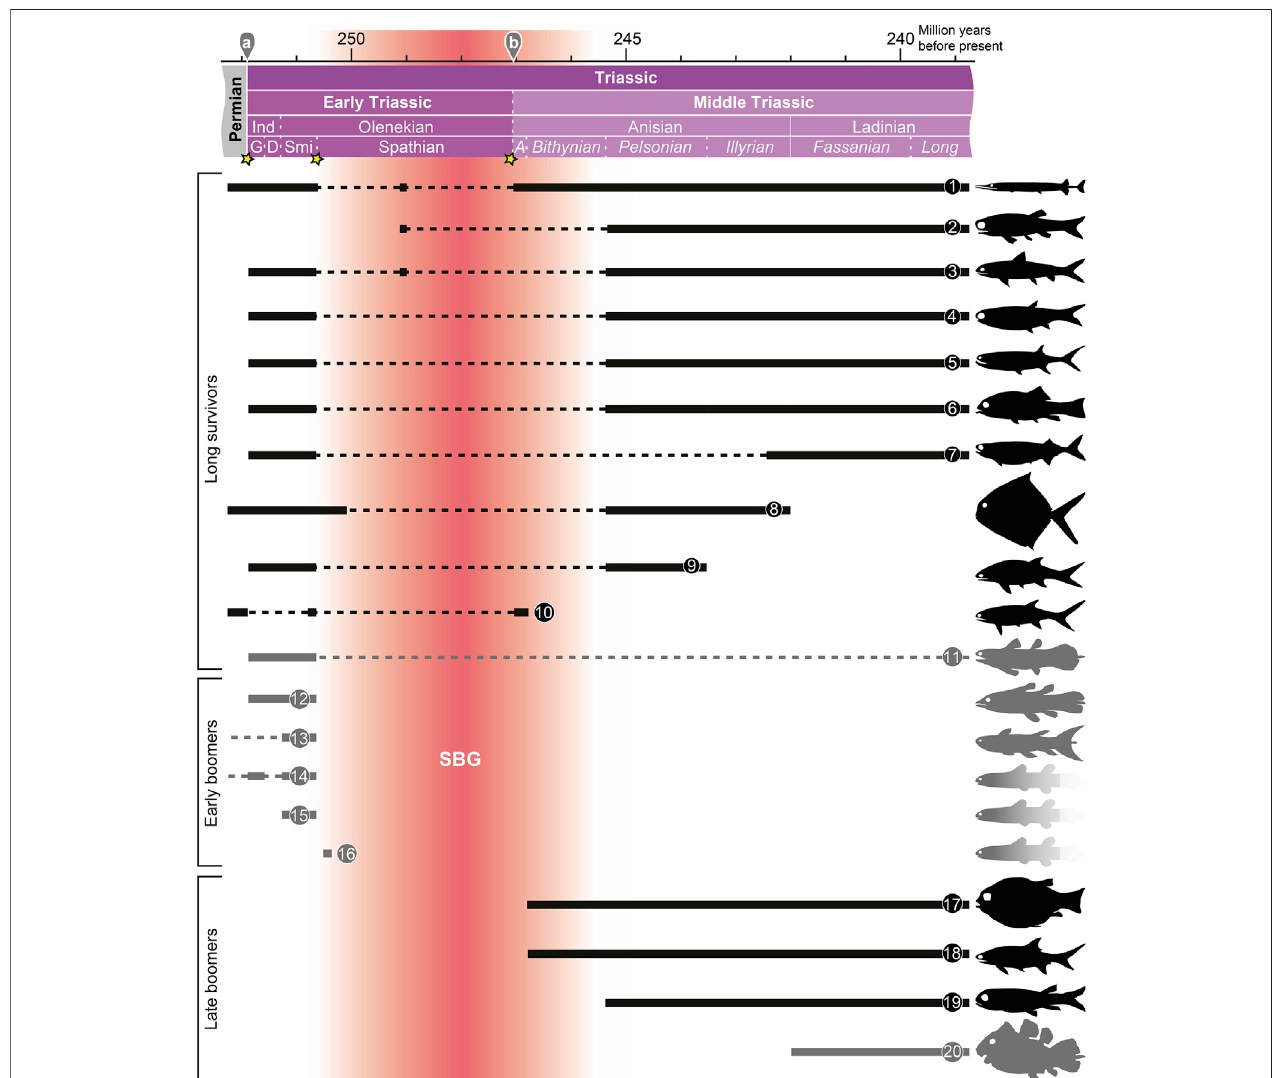
FIGURE 2| Stratigraphic ranges ofvariousgroups of bony fi shes (Actinopterygii: black; Actinistia: grey; gradient: taxa based on incompletespecimens) during the Early and Middle Triassic (Griesbachian – Fassanian). 1. Saurichthyidae ( Saurichthys ); 2. Perleididae ( Chaohuperleidus , Fuyuanperleidus , Perleidus ); 3. Ptycholepidae ( Acrorhabdus , Ardoreosomus , Boreosomus , Ptycholepis ); 4. Platysiagidae ( Helmolepis , Platysiagum ); 5. Birgeriidae ( Birgeria ); 6. Halecomorphi (e.g. Ospia , Robustichthys ); 7. Pholidopleuriformes ( Australosomus , Pholidopleurus ); 8. Bobasatraniidae ( Bobasatrania ); 9. Pteronisculus ; 10. Pygopterus ; 11. Laugiidae ( Belemnocerca , Coccoderma , Laugia , Piveteauia ); 12. Whiteia ; 13. Rebellatrix (+ Hadronector ); 14, Sasseniidae ( Sassenia , Spermatodus ); 15 Axelia + Wimania ; 16. Dobrogeria ; 17. Semionotiformes (e.g. Eosemionotus , Sangiorgioichthys ); 18. Gyrolepis ; 19. Peltopleuriformes (e.g. Peltopleurus ); 20. Latimeriidae (e.g. Foreyia ). For abbreviations for the absolute ages and stratigraphic ages: see caption of Figure 1 . See text for details.